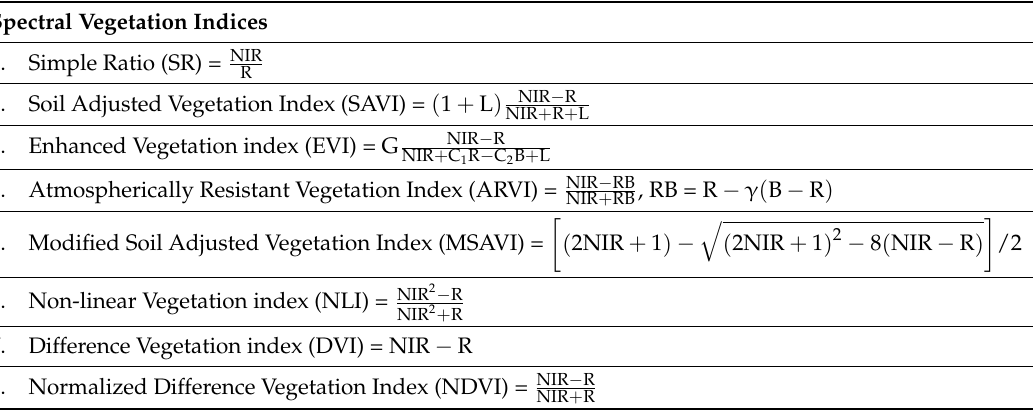
Table 2. Selected vegetation indices (VIs) used for canopy cover (CC) estimation [11].